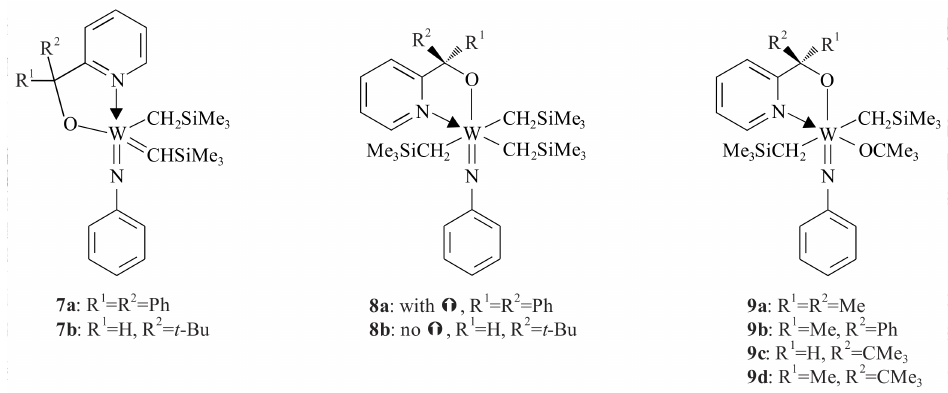
Figure 2. Tungsten(VI) phenylimido